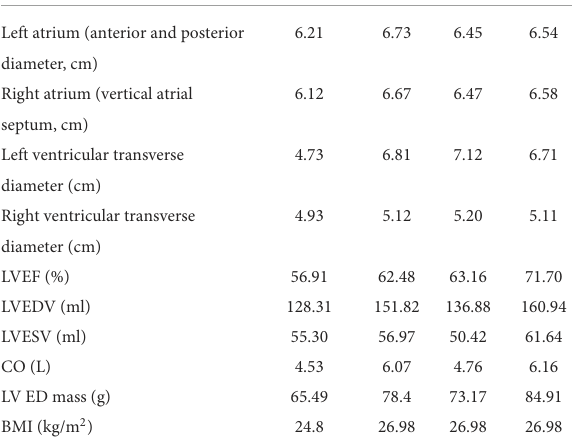
Table 2. Cine images of 4-chamber, 2-chamber, left ventricle (LV) short-axis and IVIM images of baseline are shown in Figure 2.